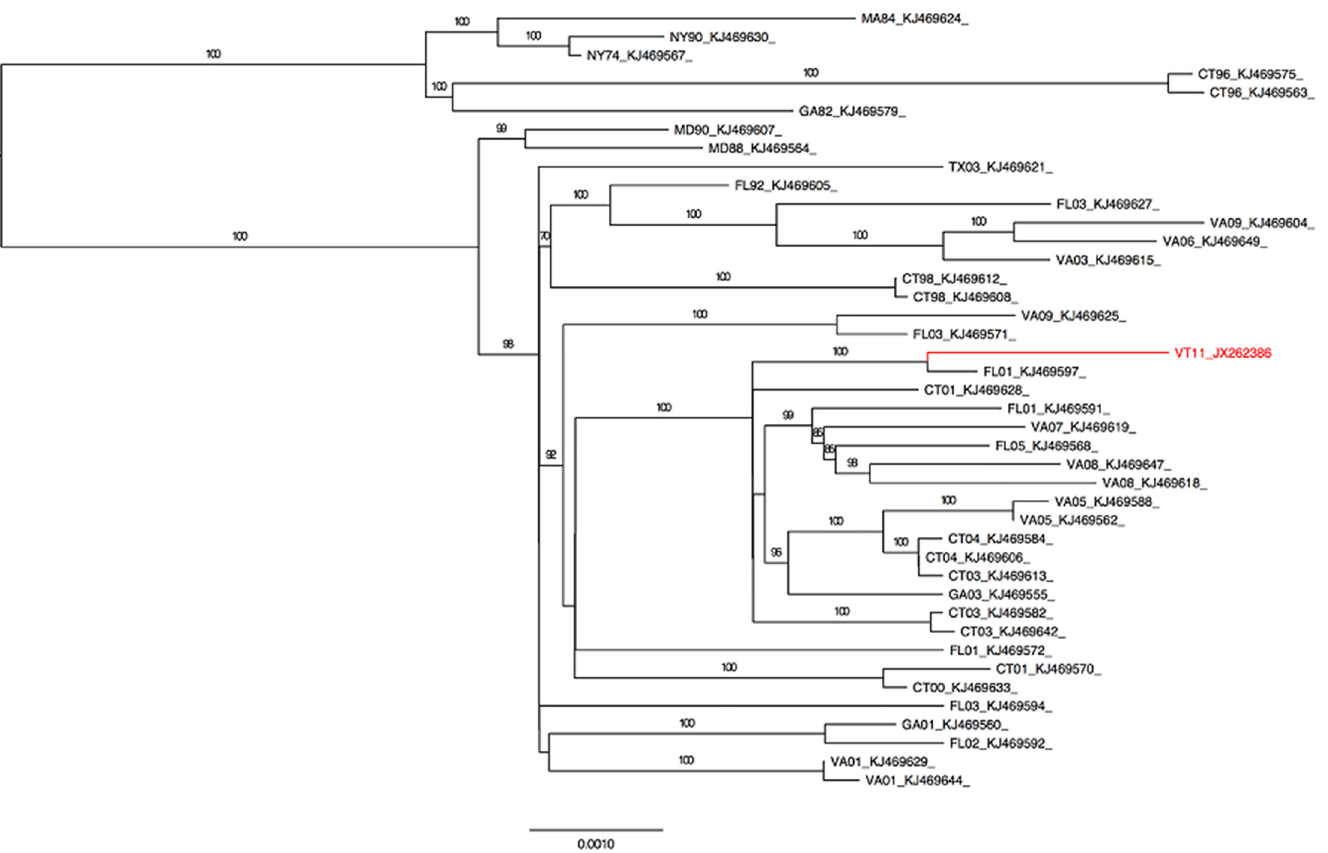
Fig 2. A maximum likelihood tree for 42 full genome sequences of EEEV isolates isolated from eastern US. VT11 is highlighted in red print. Numbers at nodes are bootstrap values based on 1000 replicates.